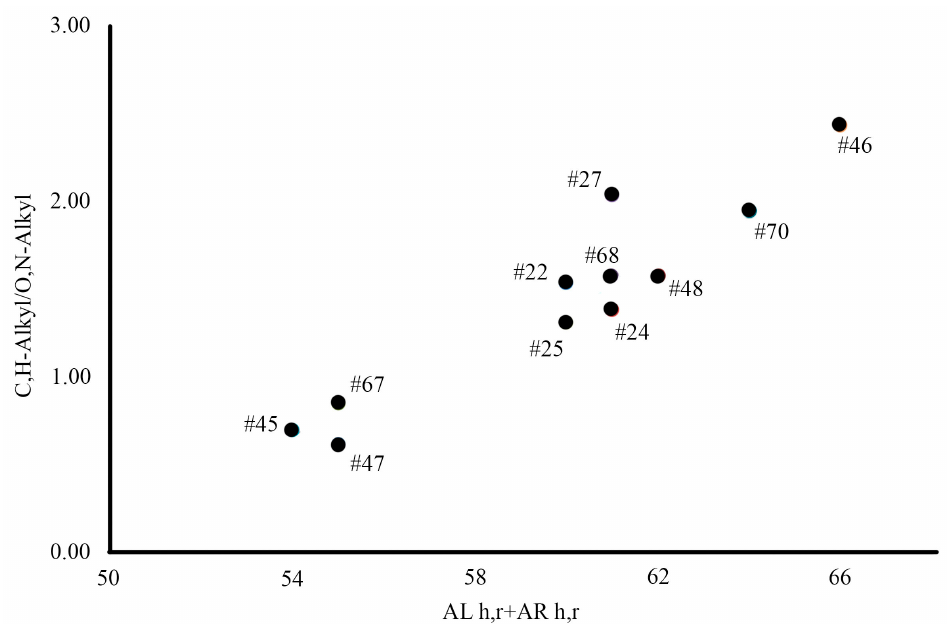
Figure 6. Diagram of the integral indicators of the molecular composition of HAs. Soil ID corre- spond to Table